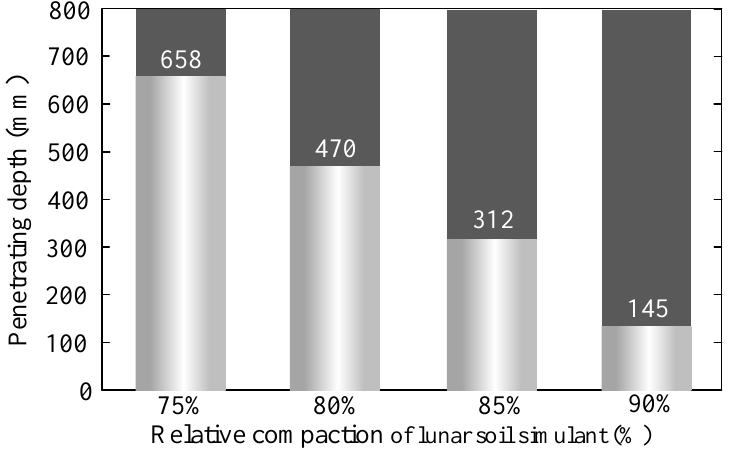
Figure 12. The penetrating depths for the penetrator to lunar soil simulant with different relative compaction values.